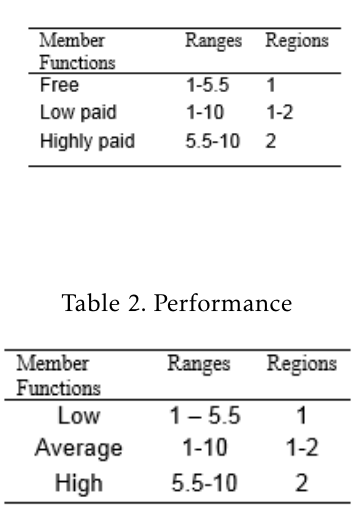
Figure 2. Cloud Mapping Module